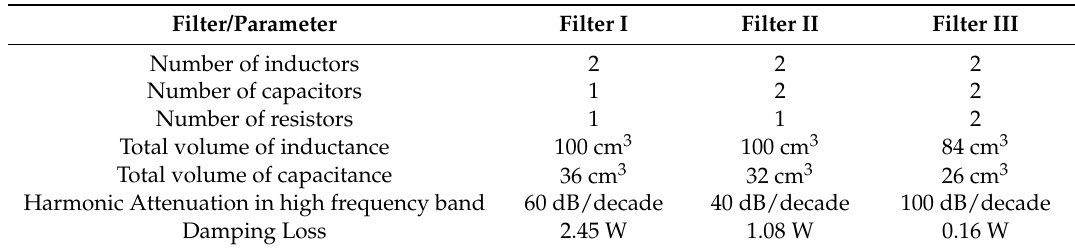
Table 4. Comparison of different filter configurations.